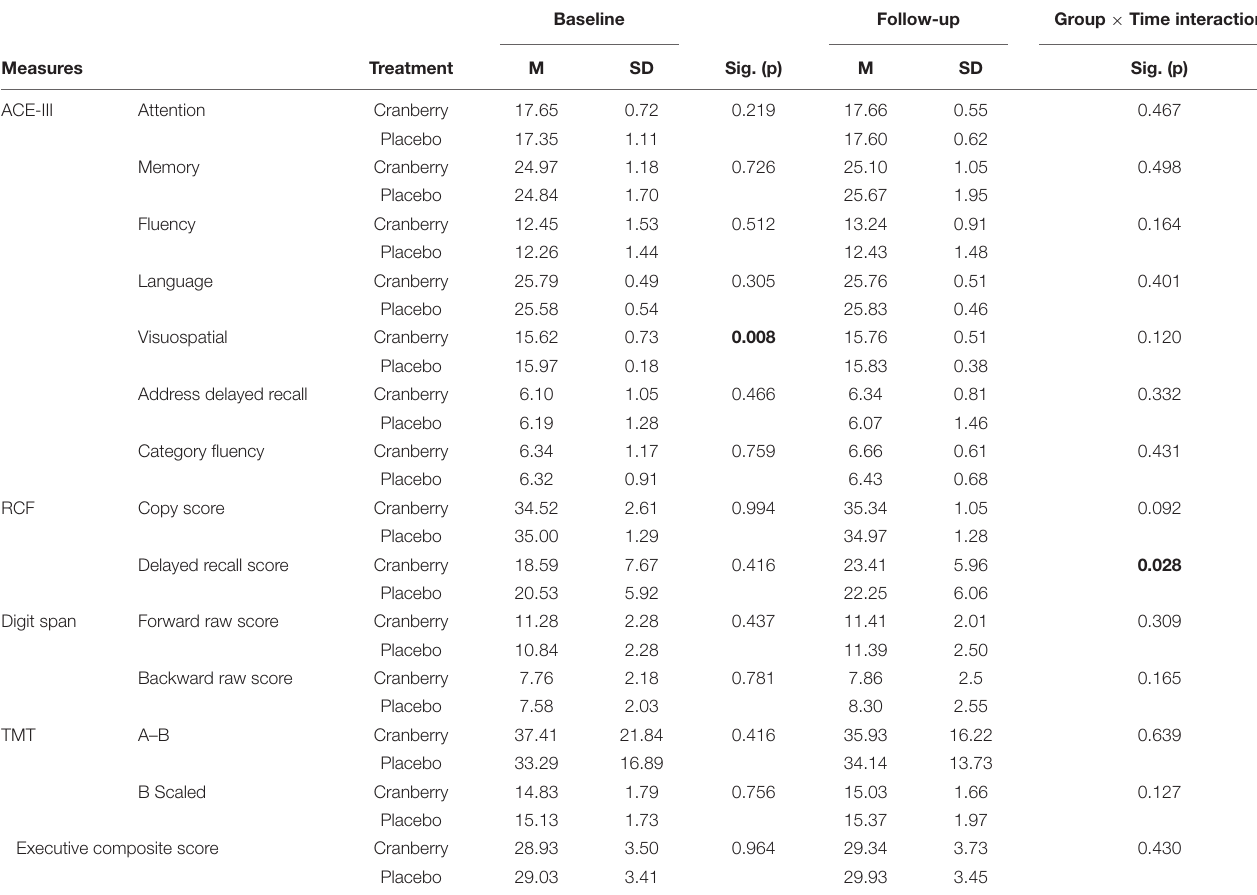
TABLE 2 | Cognitive performance at baseline and follow-up, differences between groups at baseline (Mann–Whitney U Independent-Samples Test), and group × time interactions on linear mixed modelling. Baseline Follow-up Group × Time